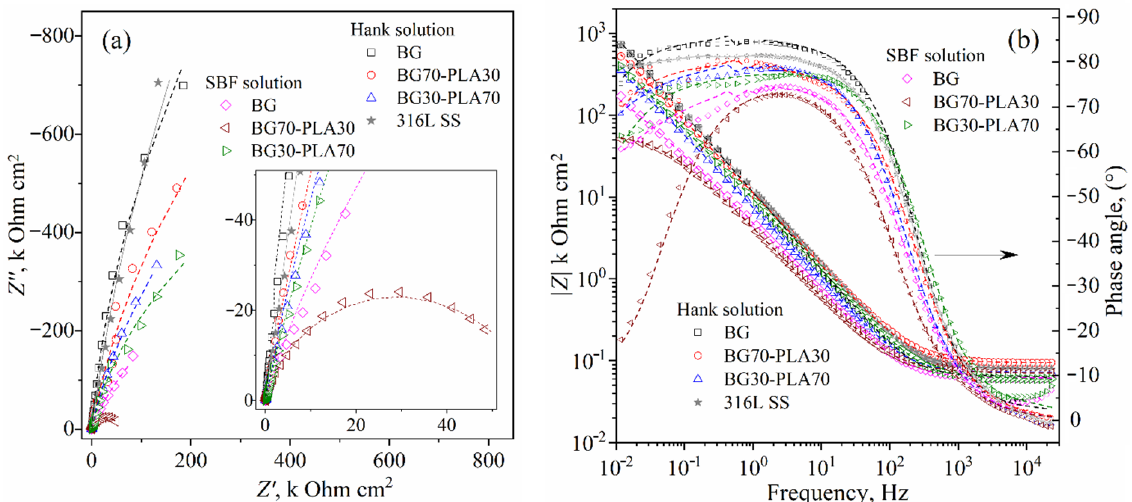
Figure 17. EIS results for BG-PLA coatings obtained at the beginning of immersion in Hank’s and SBF solutions: ( a ) Nyquist and ( b ) Bode plots. Scatter and lines indicate the experimental data and the fitting results,